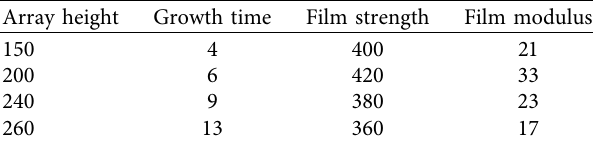
Table 2: Array height and film mechanical